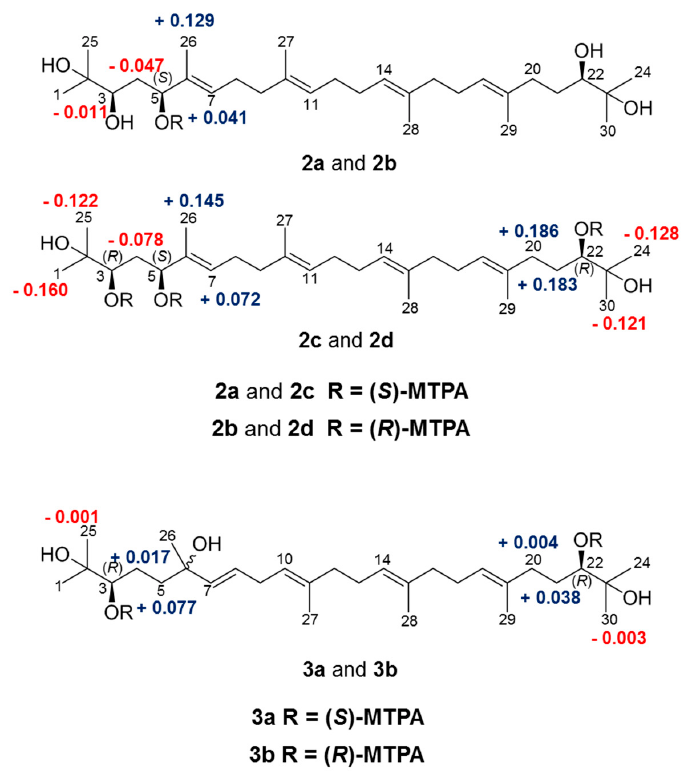
Figure 3. ∆ δ ( δ S − δ R ) values in ppm for the MTPA esters of 2 and 3 Figure 3. Δδ ( δ S − δ R ) values in ppm for the MTPA esters of 2 and 3 .